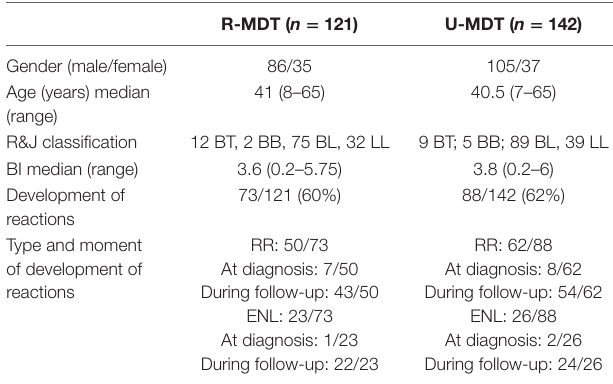
TaBle 1 | Main clinical and laboratory characteristics of the 263 MB leprosy patients enrolled at U-MDT/CT-BR stratified according to the treatment